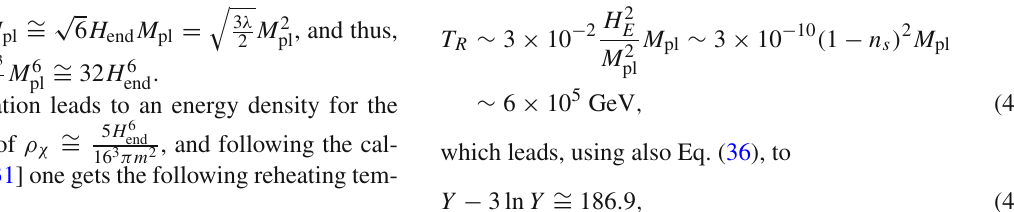
(cid:16) 3 λ M 2 , and pl 2